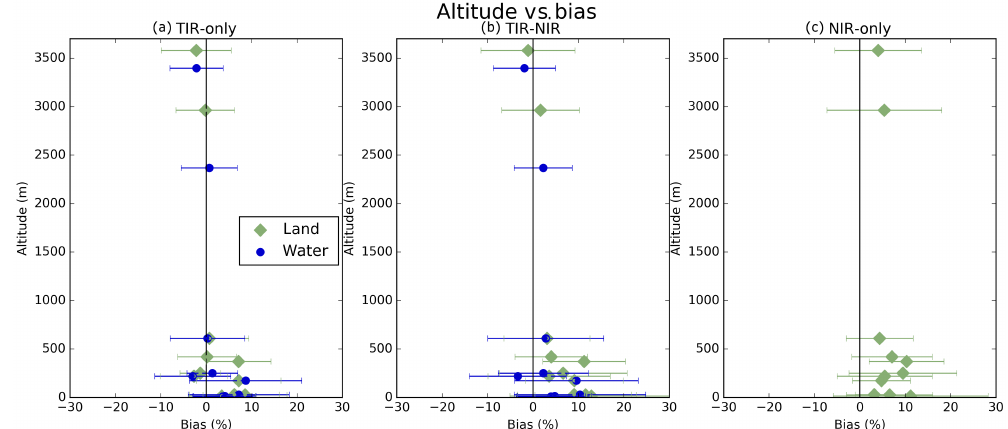
Figure 7. Altitude dependence of MOPITT relative bias ((MOPITT–FTS)/FTS). Error bars in bias plots denote standard deviations. Columns are for the different MOPITT data products – (a) TIR-only, (b) TIR–NIR, and (c)